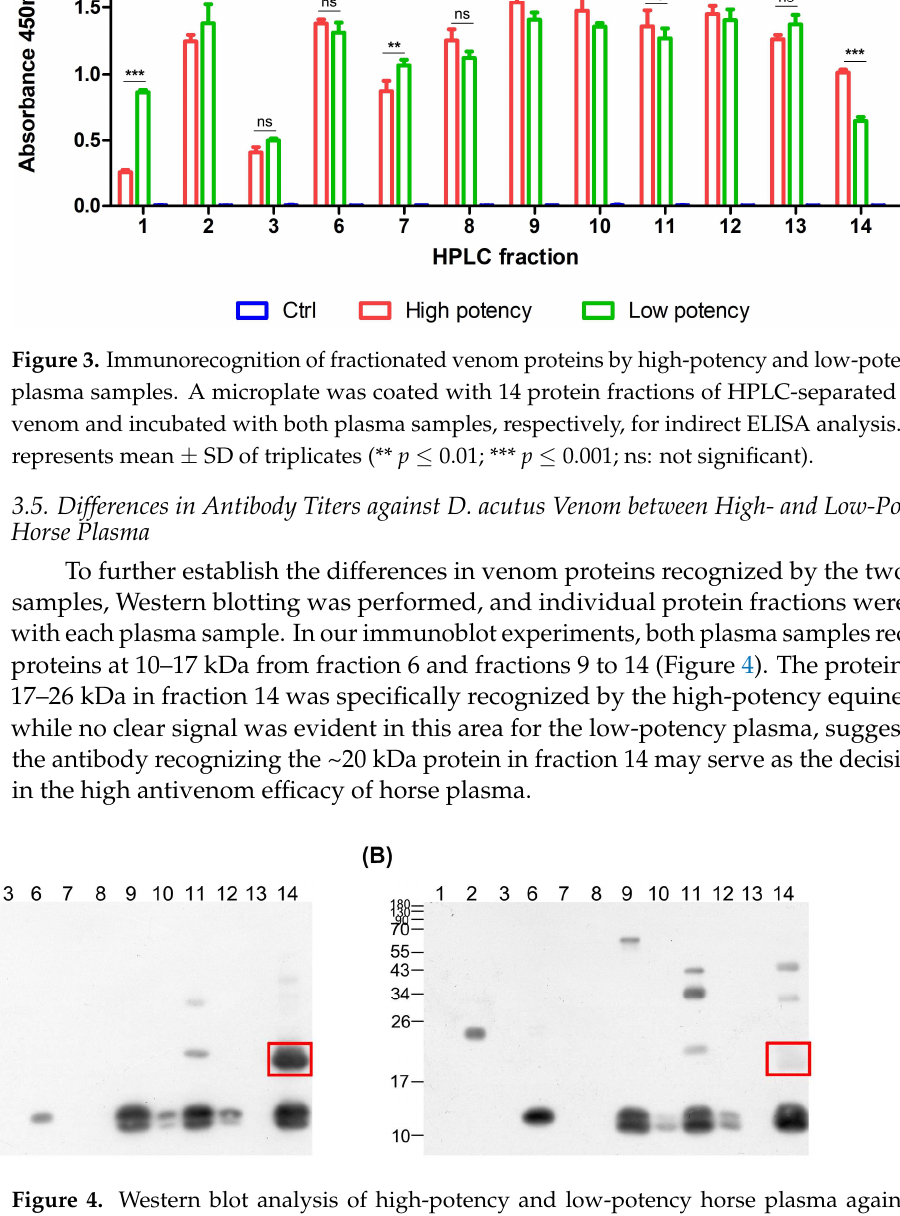
Figure 3. Immunorecognition of fractionated venom proteins by high-potency and low-potency horse plasma samples. A microplate was coated with 14 protein fractions of HPLC-separated D. acutus venom and incubated with both plasma samples, respectively, for indirect ELISA analysis.